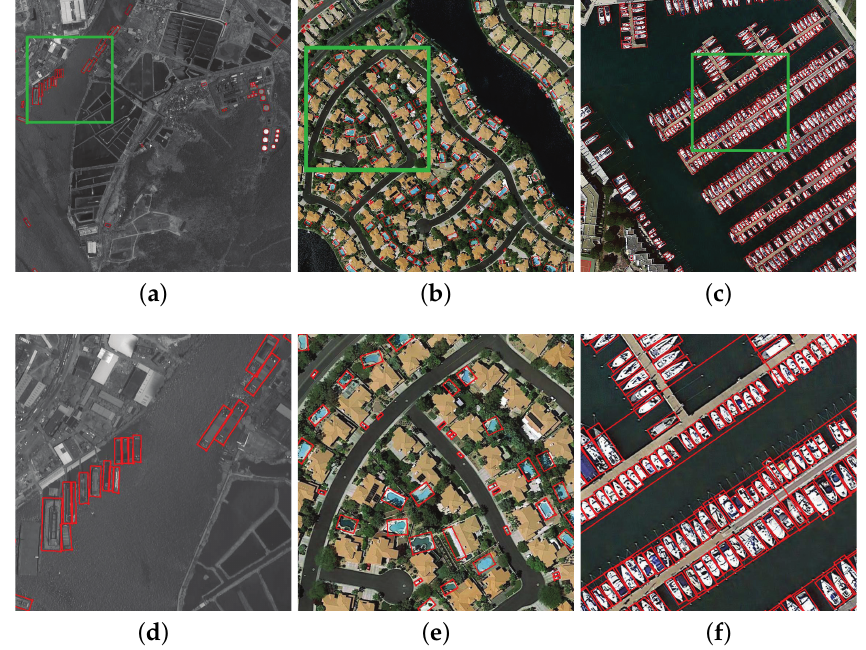
Figure 1. Illustration of detection results produced by F 3 -Net. ( a – f ) Thanks to the feature fusion module and feature filtration module, the objects with small sizes, dense arrangement, varied appearance, and cluttered environment are accurately detected and